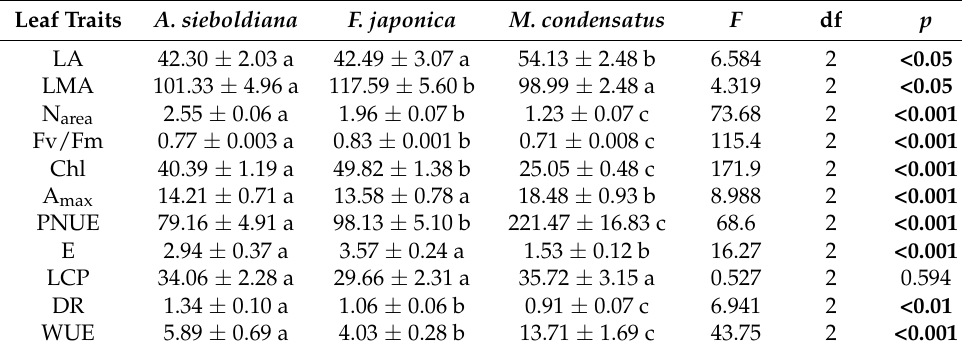
Table 3. Mean ( ± SE, n = 15) leaf trait values of three pioneer species in the volcanically devastated site in Miyake-jima. Data analyzed using one-way ANOVA with a post hoc Tukey HSD test. All variables were log10-transformed prior to analysis. Significant differences at p < 0.05 among species are shown in different letters. Full names of leaf traits are given in Table